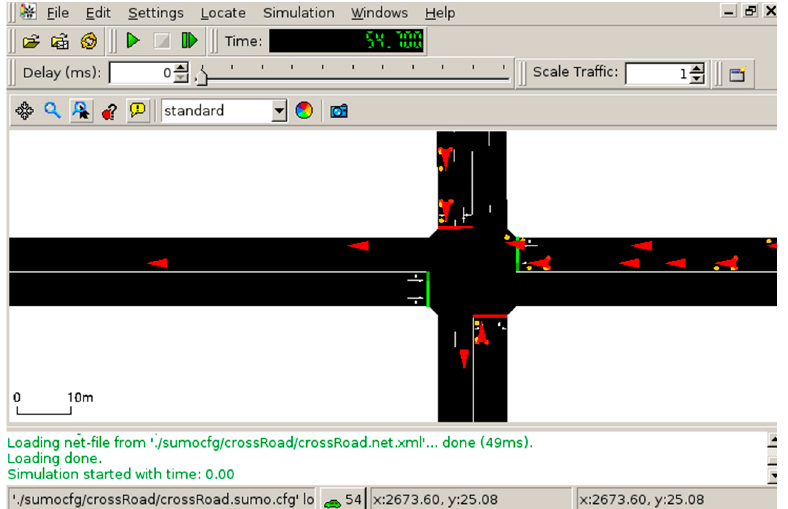
Figure 4. The road environment of the Veins simulation. The black line is rad and red triangles are vehicles.